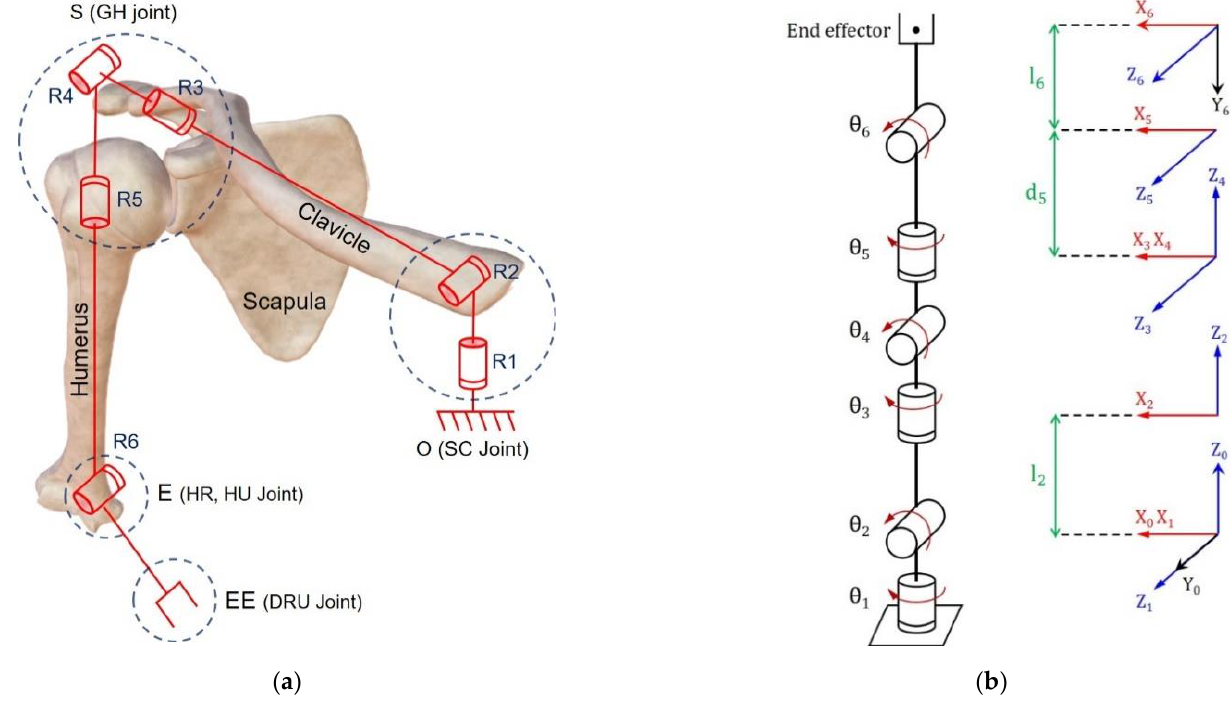
Figure 3. Shoulder complex modeling. ( a ) Mechanism of the shoulder complex model with rotation joints. ( b ) Forward kinematics modeling of the shoulder complex with a relative position coordinate system.